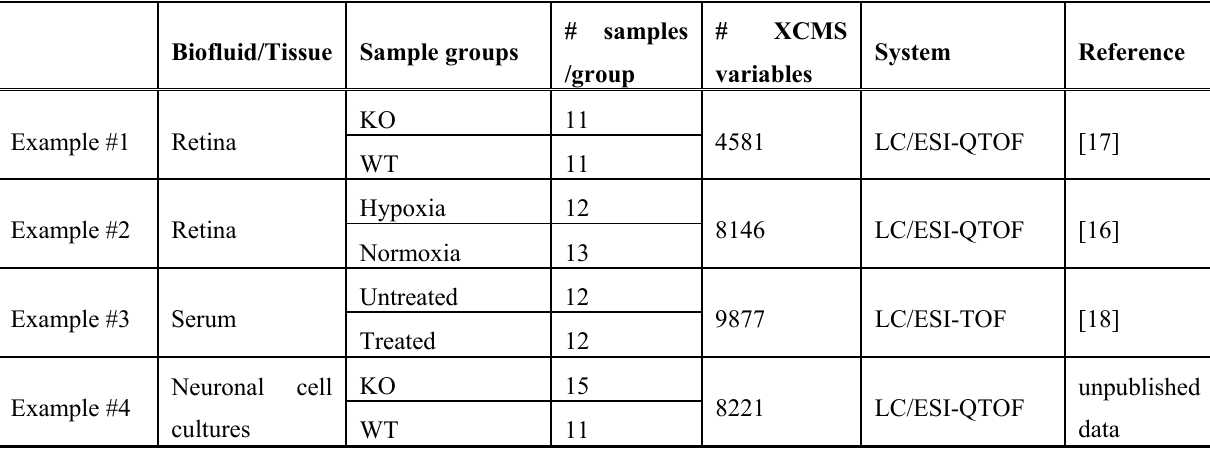
Table 1. Summary of working examples obtained from LC-MS untargeted metabolomic experiments. Further experimental details and methods can be obtained from references. (KO=Knock-Out;